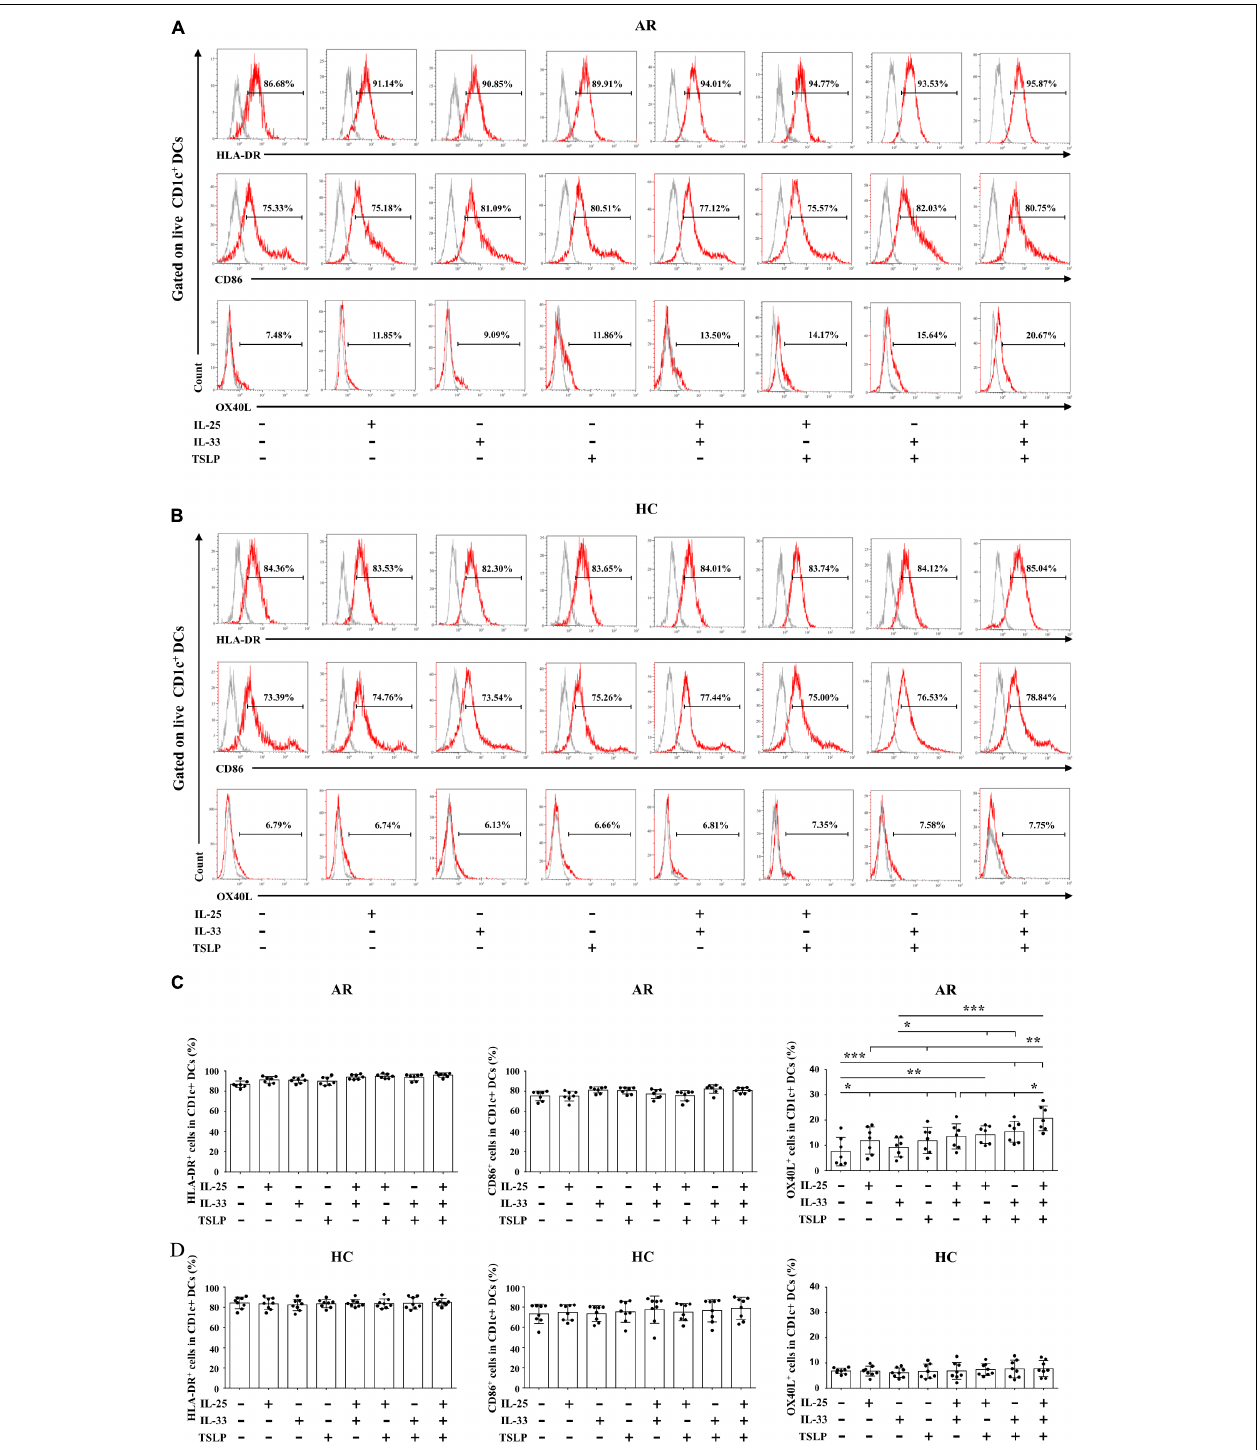
FIGURE 3 | Effects of IL-25, IL-33, and TSLP on the phenotype of mo-DCs. (A,B) Representative flow plots of HLA-DR, CD86, and OX40L expression on Der.p1-induced mo-DCs from AR ( n = 7) and HC ( n = 8) subjects cultured in the presence of IL-25, IL-33, and TSLP, singly or in combination, for 24 h. Gray histograms were negative isotypes. (C,D) Quantification of percentages of HLA-DR + , CD86 + , and OX40L + cells in Der.p1-induced mo-DCs. Data are expressed as means ± SD. Significant differences were tested using the paired t -test between control and cytokine stimulation groups, and using Student’s t -test between cytokine stimulation groups. * P < 0.05, ** P < 0.01, *** P < 0.001.